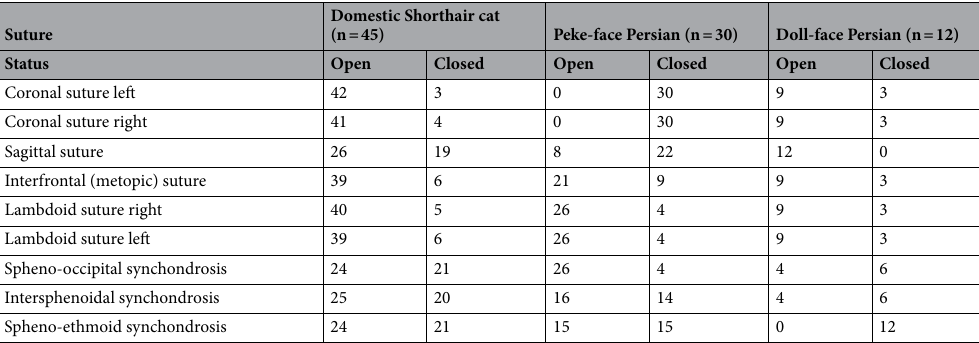
lambdoid sutures (S5/6) (Fig. 1), as well as intersphenoidal synchondrosis (S7), spheno-occipital synchondrosis (S8) and spheno-ethmoid synchondrosis (S9) (Fig. 1). Each suture and synchondrosis was examined in both 2D MCT slices in orthogonal views and on the surface of the 3D skull models. Using the graphical software, landmark lines were set on the area of interest in the skull model. The same landmarks were shown in all 2D planes supporting the correct identification of a suture or synchondrosis (Fig. 2). In each specimen, the state of the sutures was coded as either open or closed. Sutures were viewed across the entire length of the suture in ques- tion. Sutures and synchondroses that were partially fused were classified as closed. An open synchondrosis or suture was defined as a hypodense, non-calcified zone between well-defined hyperdense borders of the calvaria or cranial base bones (Fig. 2). A closed suture or synchondrosis was defined as a continuous hyperdense bone signal, without interruption by a hypodense zone (Fig. 3).